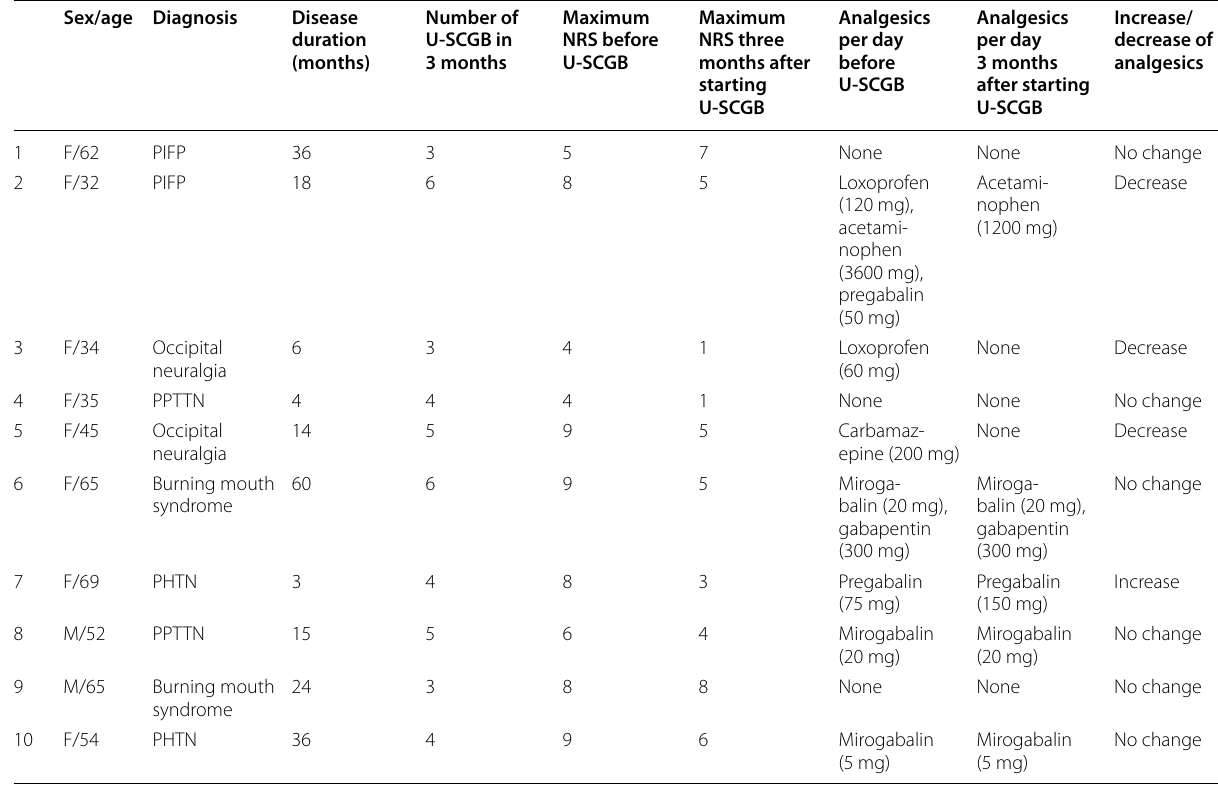
Table 1 Diagnosis, disease duration, and number of ultrasound-guided SCG blocks of each case and changes in maximum NRS and analgesic